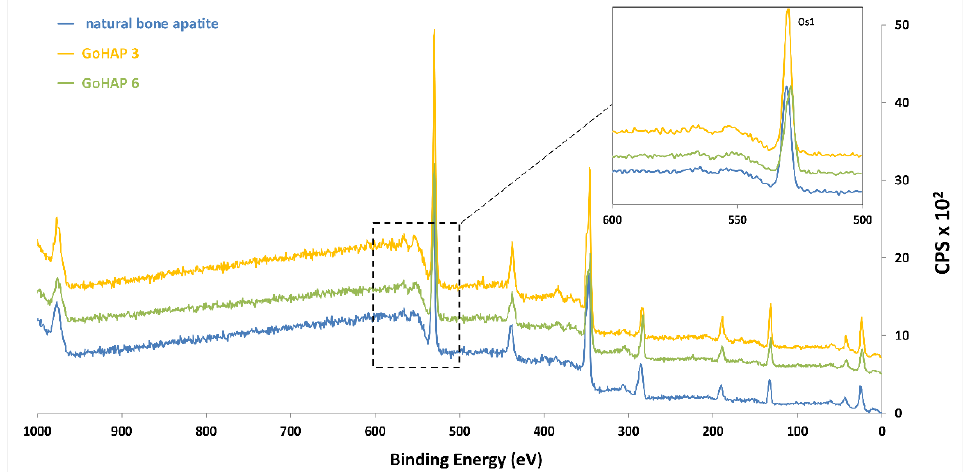
Figure 6. XPS spectra of GoHAP 3 and 6 powders compared with natural bone apatite.